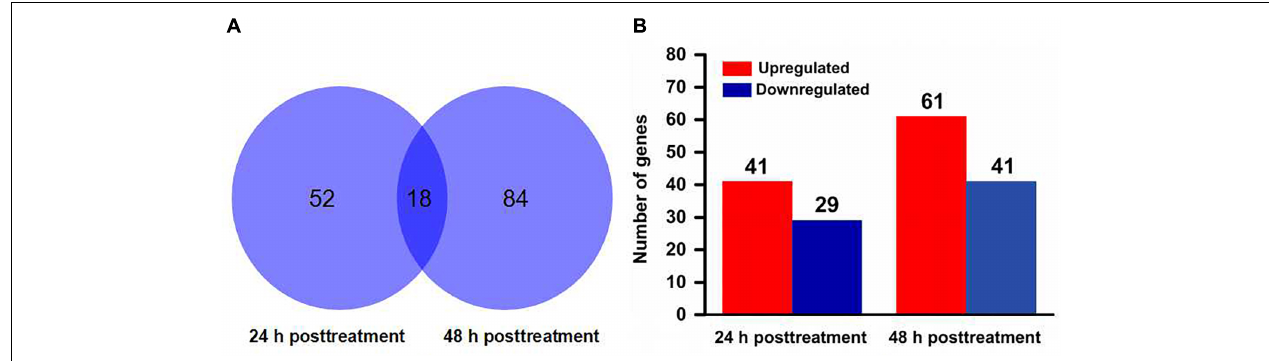
FIGURE 2 | Distribution of differentially expressed genes in Tetranychus cinnabarinus in response to scopoletin. (A) Venn diagram showing the total number of differentially expressed genes at 24 and 48 h posttreatment, and the number of overlapped genes between two time points. (B) The number of up-regulated and down-regulated genes at 24 and 48 h after scopoletin